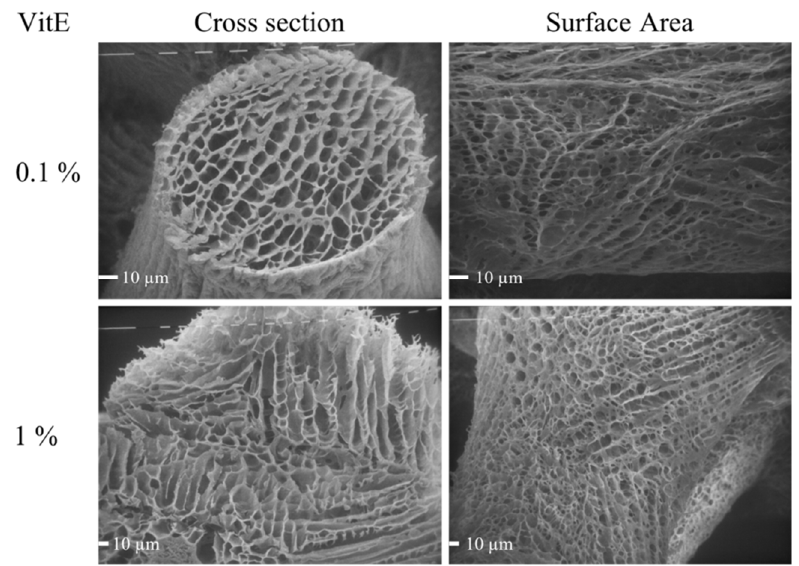
Figure 3. SEM photographs of freeze-dried VitE 0.1 and VitE 1 scaffolds. View of surface area and cross section. VitE 0.1 Mag: 360×; VitE 1 Mag 640×. cross section. VitE 0.1 Mag: 360 × ; VitE 1 Mag 640 ×